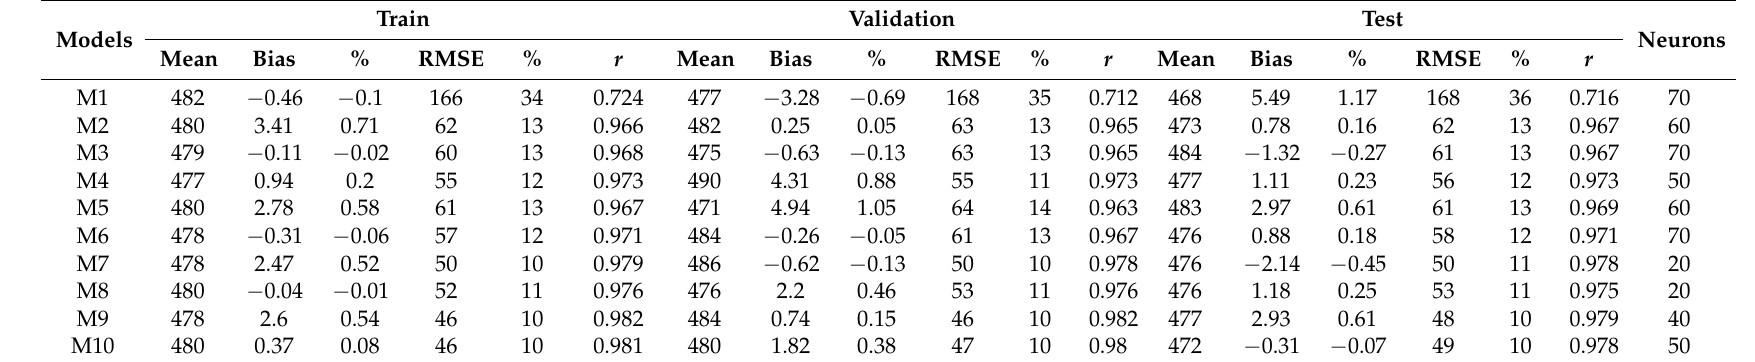
Table A7. As in Table A1, but for Bazian automatic station.